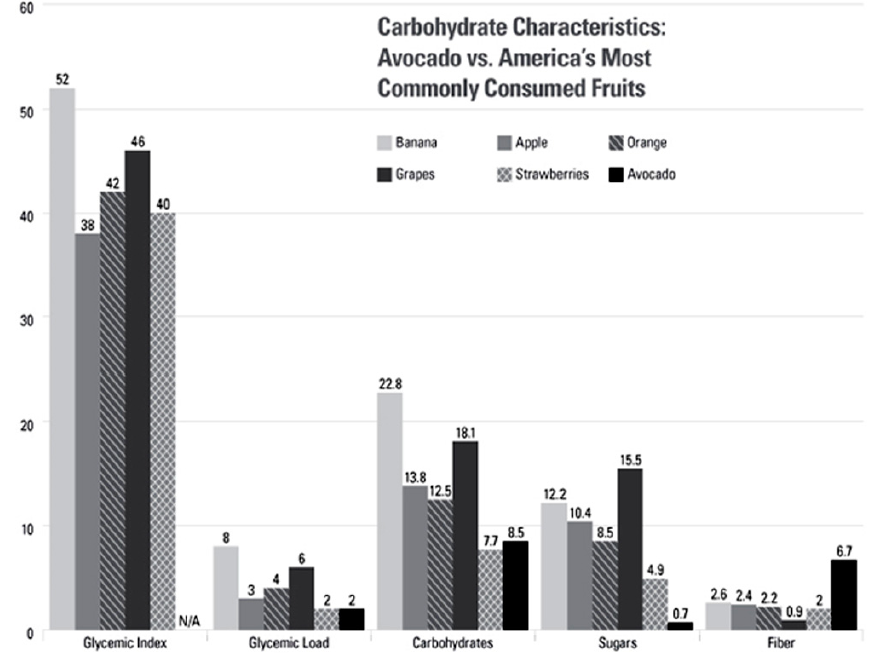
Figure 1. Carbohydrate Characteristics: Avocado vs. America’s Most Commonly Consumed Fruits. Glycemic Index Scale: Glucose = 100. Carbohydrates, sugars, and fiber are all listed per 100 g serving. There are no glycemic index values given for avocados because they contain so few carbohydrates that it would be difficult for people to consume a large enough portion (50 g of available carbohydrates) to properly perform glycemic index testing. Data sources: Nutrients—USDA Nutrient Database for Standard Reference 27 [47,48]; Glycemic Load and Glycemic Index—International table of